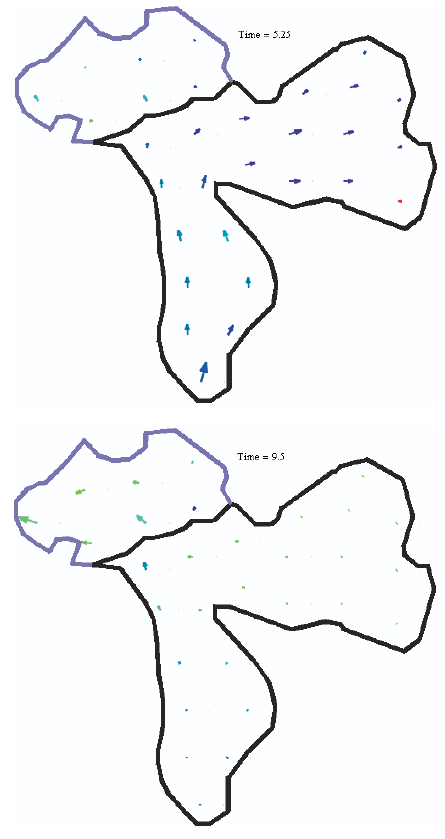
Fig. 12. Velocity vectors during filling (top) and emptying (bottom) of the P1+P3 polder system. The longest vector corresponds to a magnitude of